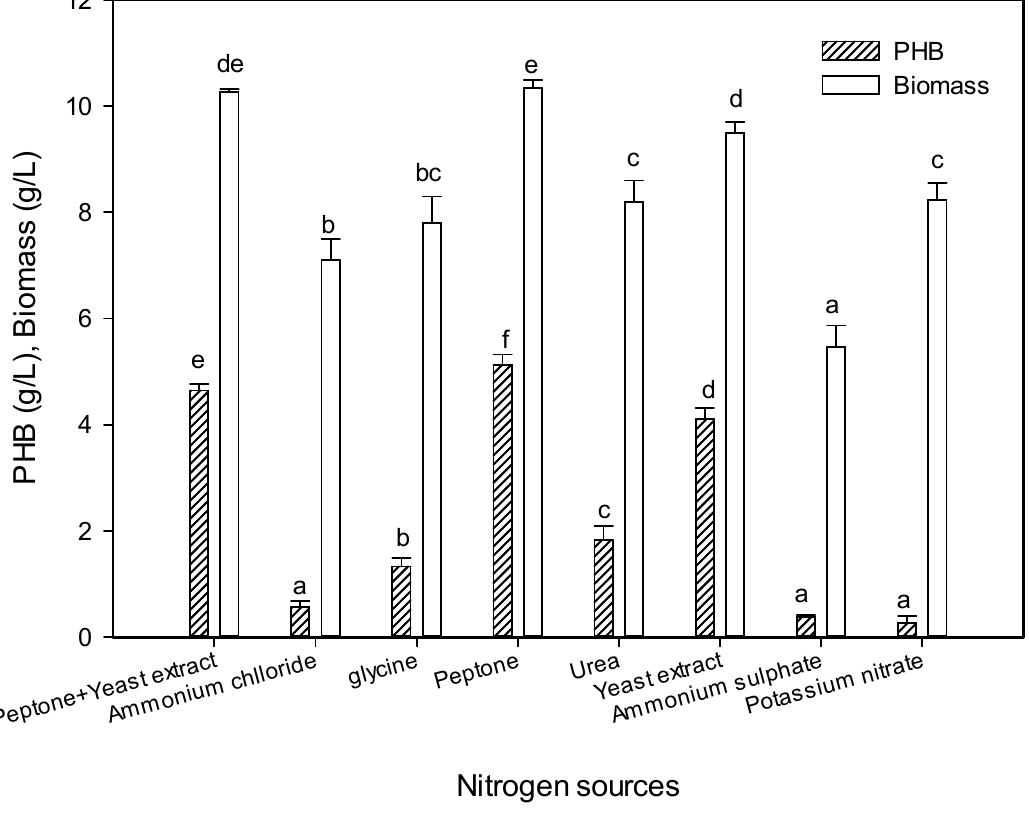
Figure 9. Effect of nitrogen source on the PHB production by E. aquimaris . The values set by oneself letter(s) on the same column were not significantly different.